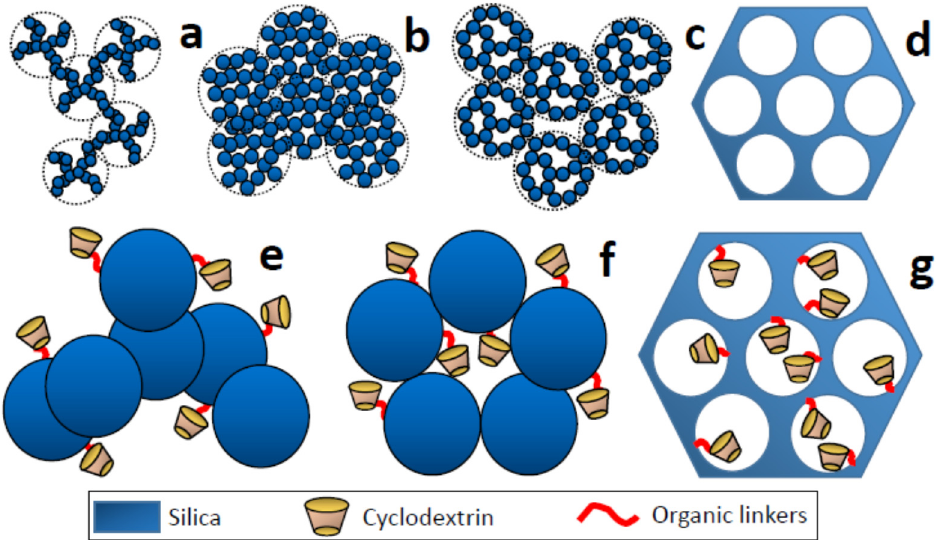
Figure 2. Schematic representation of the structures of ( a ) fumed silica, ( b ) silica xerogel, ( c ) silica aerogel, ( d ) mesoporous silica, ( e ) CD-modified fumed silica, ( f ) CD-modified xerogel or aerogel, and ( g ) CD-modified mesoporous silica.